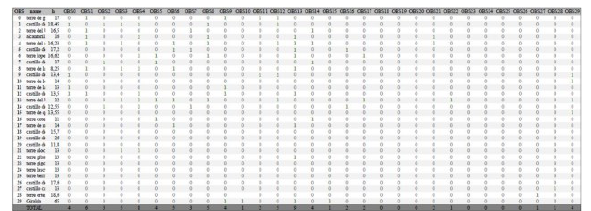
Figure 10. Table showing the visual lines between towers considering the distance of de 20km.